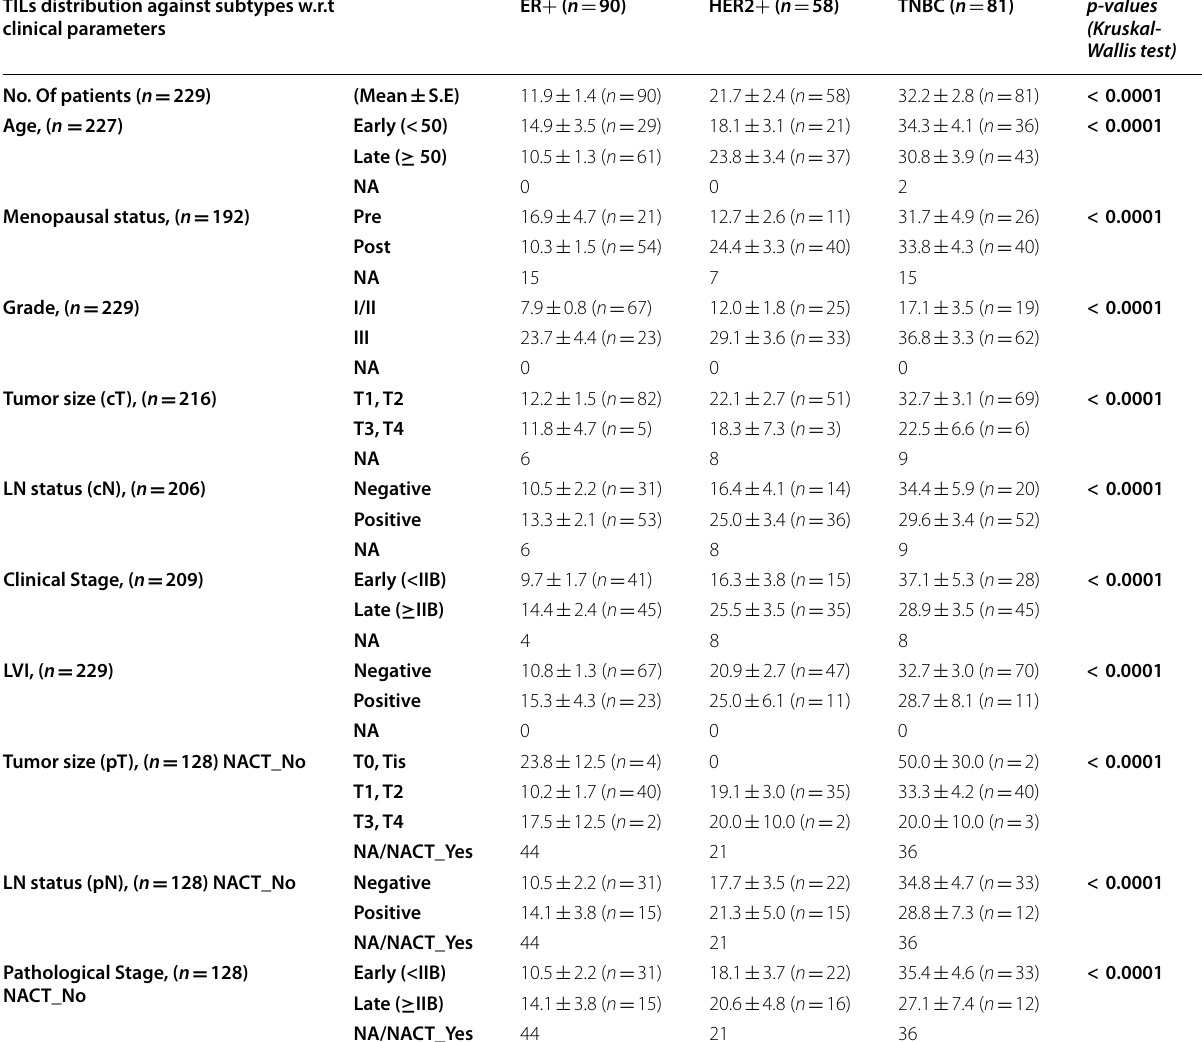
Mean S.E sTILs scores according to the molecular subtypes are presented across clinicopathological parameters including age at diagnosis, menopausal status of ± patients, tumor grade, radiological and pathological tumor size, lymph node status and stage, and LVI The statistical analysis was performed using GraphPad Prism v.5. Kruskal Wallis test was performed to compute the significance for mean sTILs scores across breast cancer subtypes. The bold font indicates significant p-values. *LVI- lymphovascular invasion